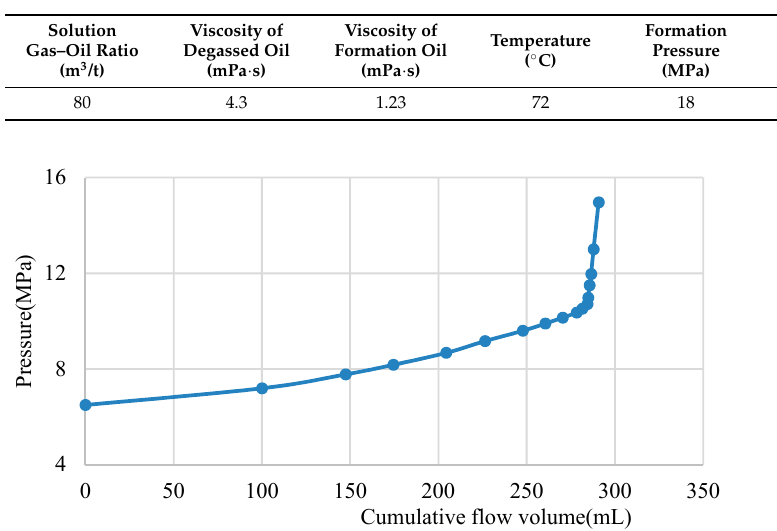
Figure 2. A sketch of the Jamin effect.